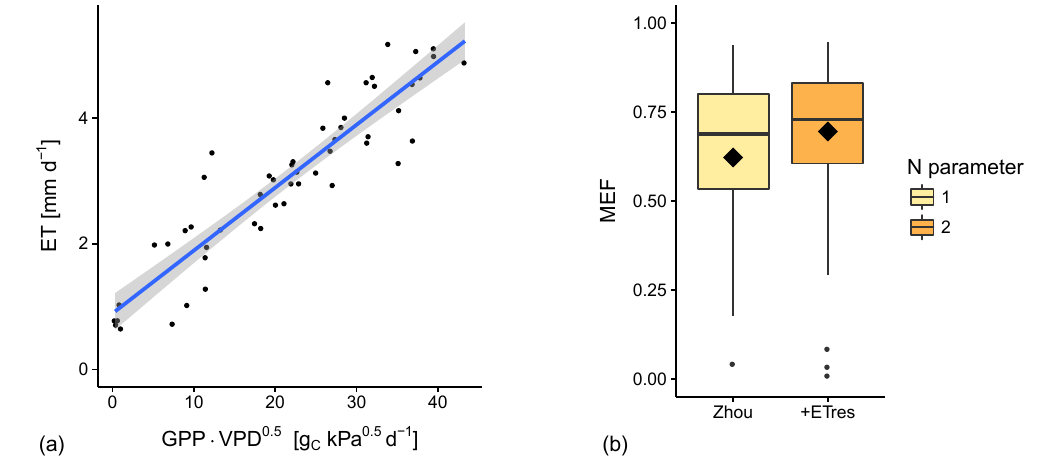
Figure 1. Linear regression between the product of GPP and VPD 0 . 5 and the daily ET; the shaded area indicates the 95% confidence interval of the mean of the predictions (a) . Model performance of the Zhou model compared to the + ET res variant (b) . The thick horizontal lines of the box plots denote the median; the diamonds denote the mean of the MEF of all